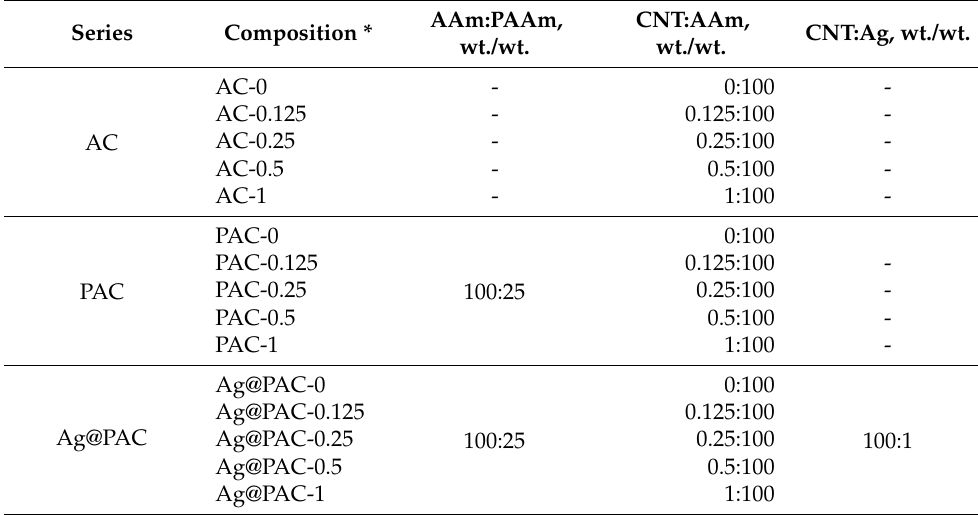
Table 1. Synthesized materials’ denomination and composition of the polymerization